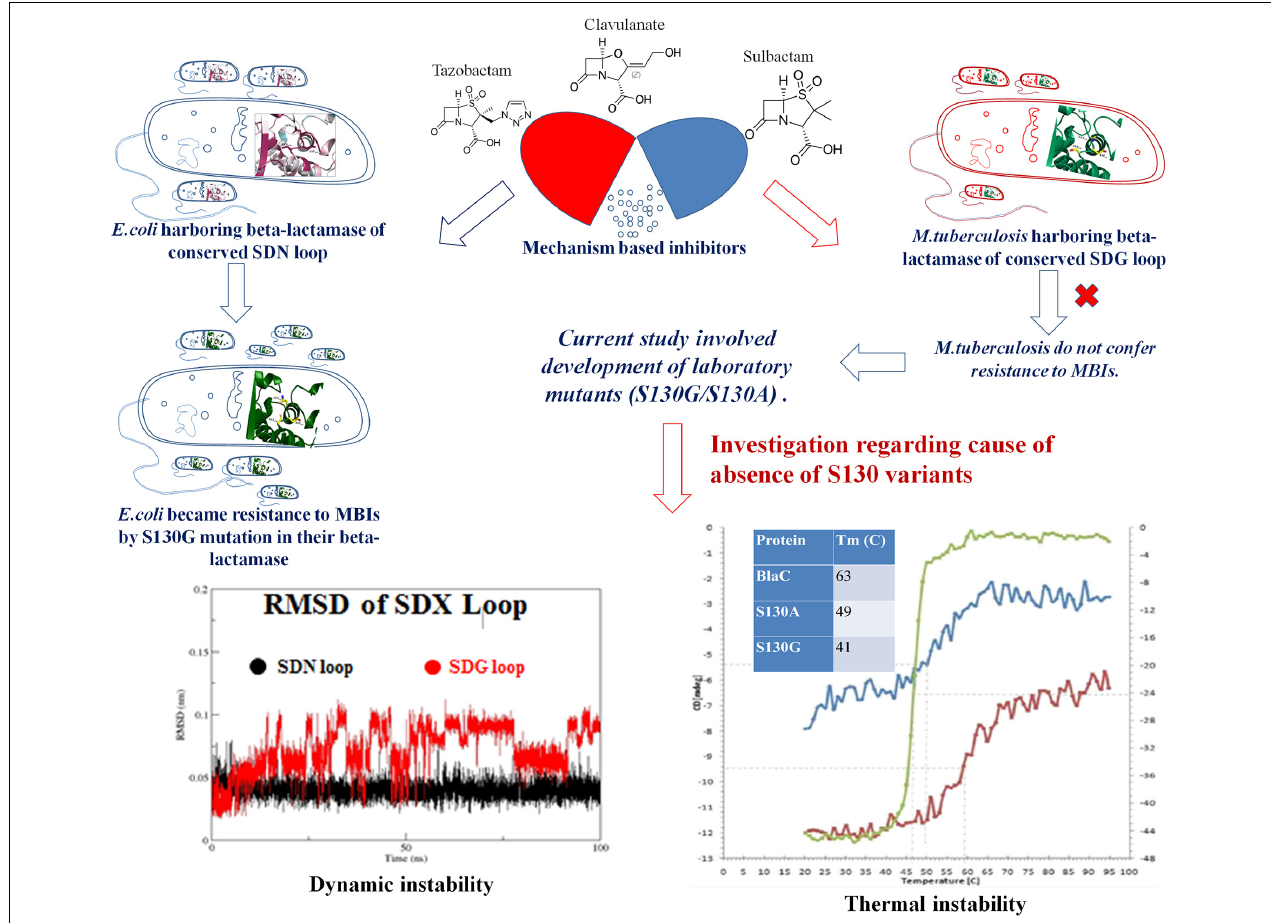
FIGURE 7 | A conclusion model to describe the problem statement and outcomes from the